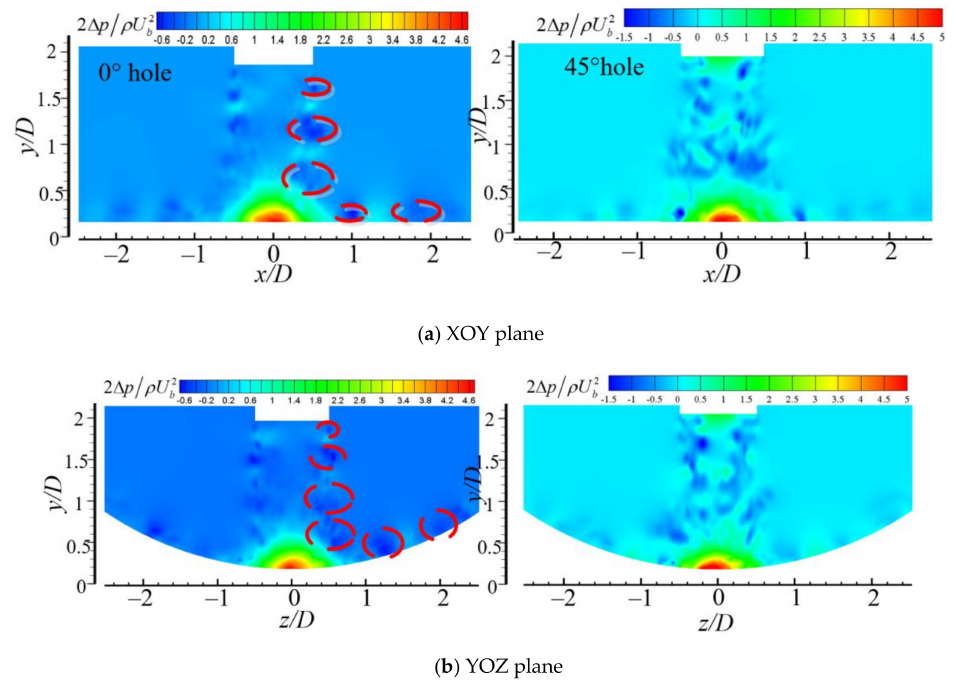
Figure 7. The distribution of pressure in the XOY and YOZ